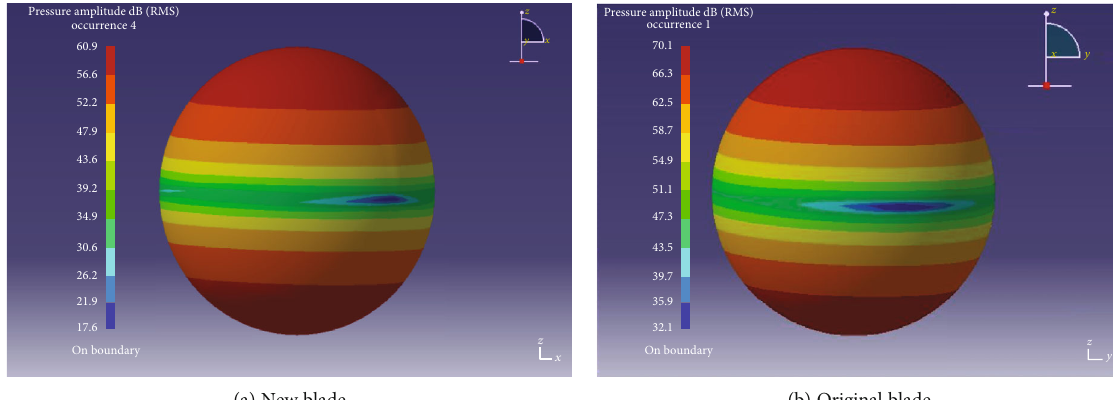
Figure 12: 1500 rpm spherical fi eld sound pressure cloud.